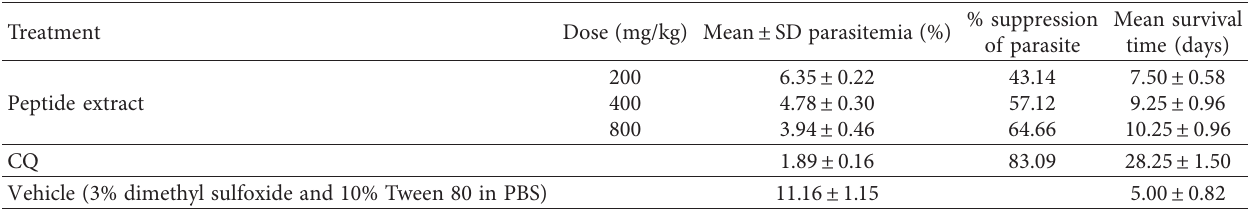
Table 5: In vivo antimalarial activities of crude extract of Glycine max in prophylactic test on day 4 postparasite exposure and animal survival